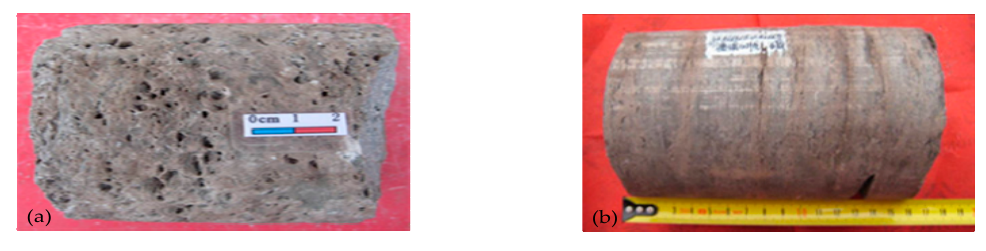
Figure 2. Core samples from the carbonate gas reservoir of Anyue gas field. ( a ) Core sample with vugs and pores; ( b ) Core sample with micro fractures. Table 1. Some properties of carbonate core samples used in this study.